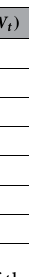
Table 1. Inverse of the precision as a function of the averaging time t /